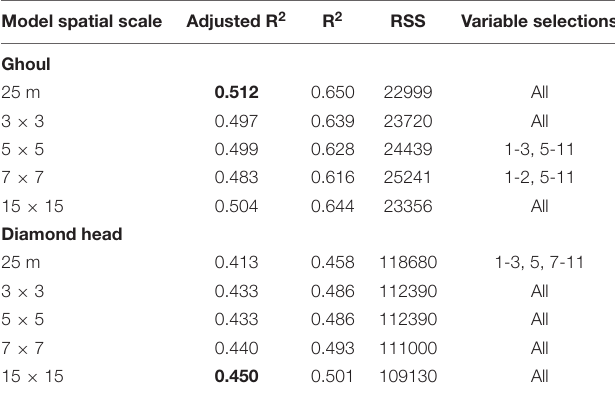
TABLE 4 | DistLM results for the compared models.